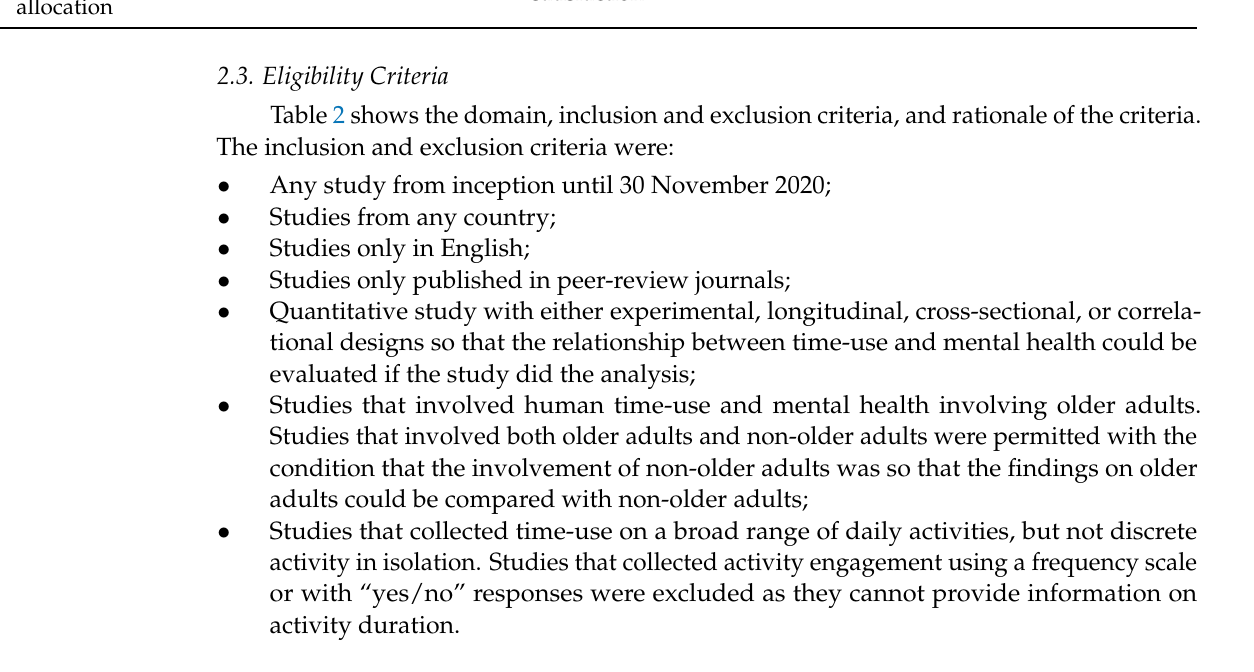
Table 2. Inclusion and exclusion